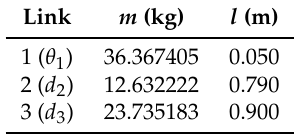
Table 1. Values of masses ( m ) and lengths ( l ) of each link.